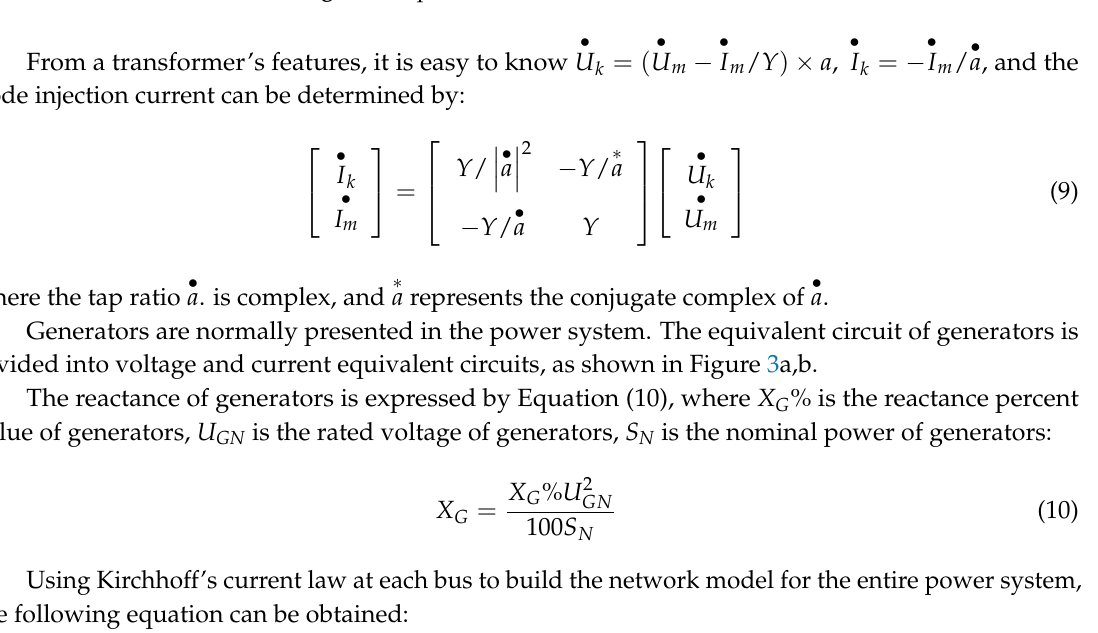
Figure 2. Equivalent circuit for a transformer.